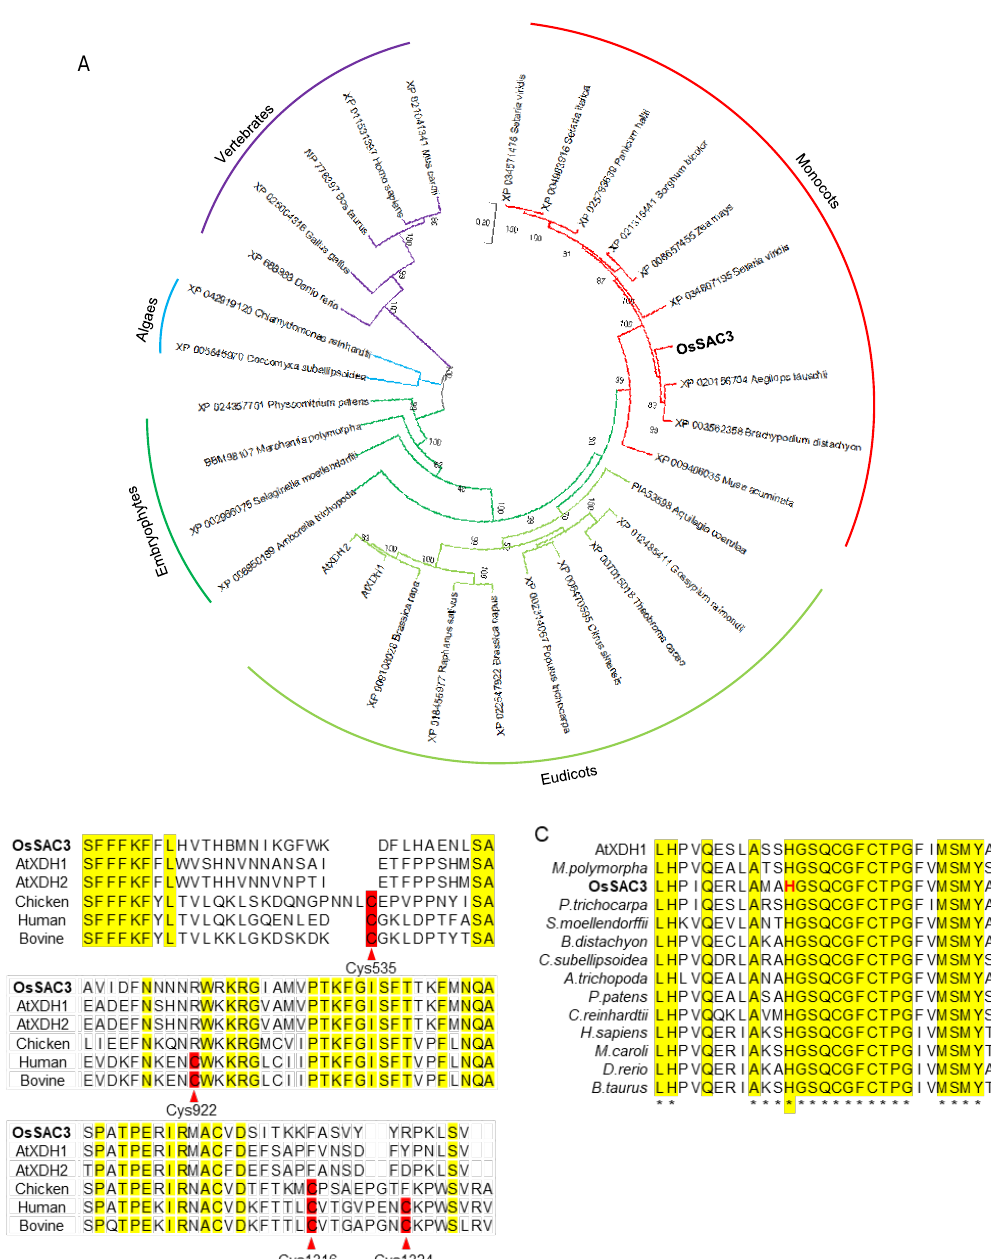
Figure 2. Bioinformatic analysis of OsSAC3. ( A ): Phylogenetic analysis of OsSAC3 revealed that the xanthine dehydrogenase, encoded by OsSAC3 was conserved among the eukaryotes and was classified into the monocots; ( B ): The four Cys residues (Cys 535, 922 1316 1324) functioned in the tran- sition from xanthine dehydrogenase to xanthine oxidase were missing in OsSAC3, AtXDH1/2 and Chicken (XP_025004316); ( C ): Conserved sequence of [2Fe-2S] center in OsSAC3 and H124, marked in red color, was mutated into Leu in ossac30 ; M. polymorpha ( Marchantia polymorpha , BBM98107), P. trichocarpa ( Populus trichocarpa , XP_002314067), S. moellendorffii ( Selaginella moellendorffii